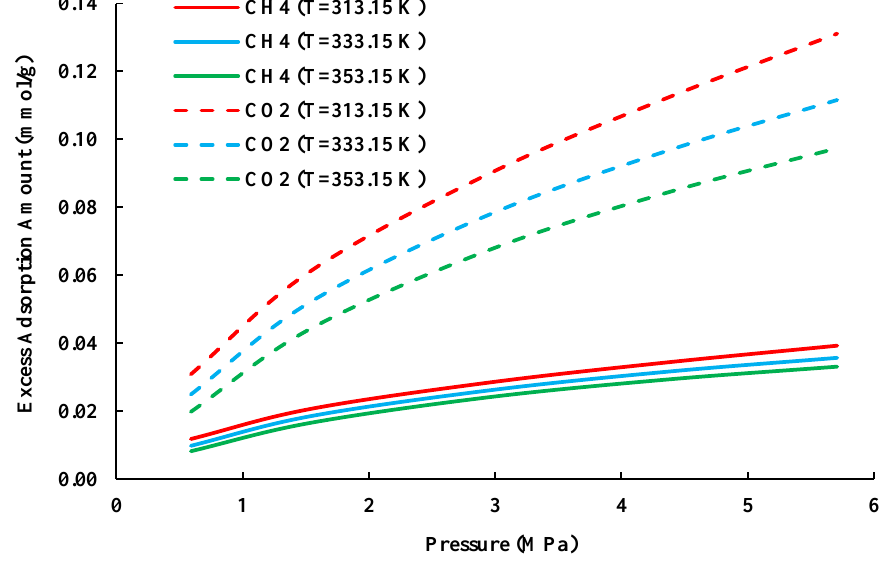
Figure 5. Excess adsorption isotherms of each component in CH 4 /CO 2 (50/50) mixture in shale at 313.15, 333.15, and 353.15 K.